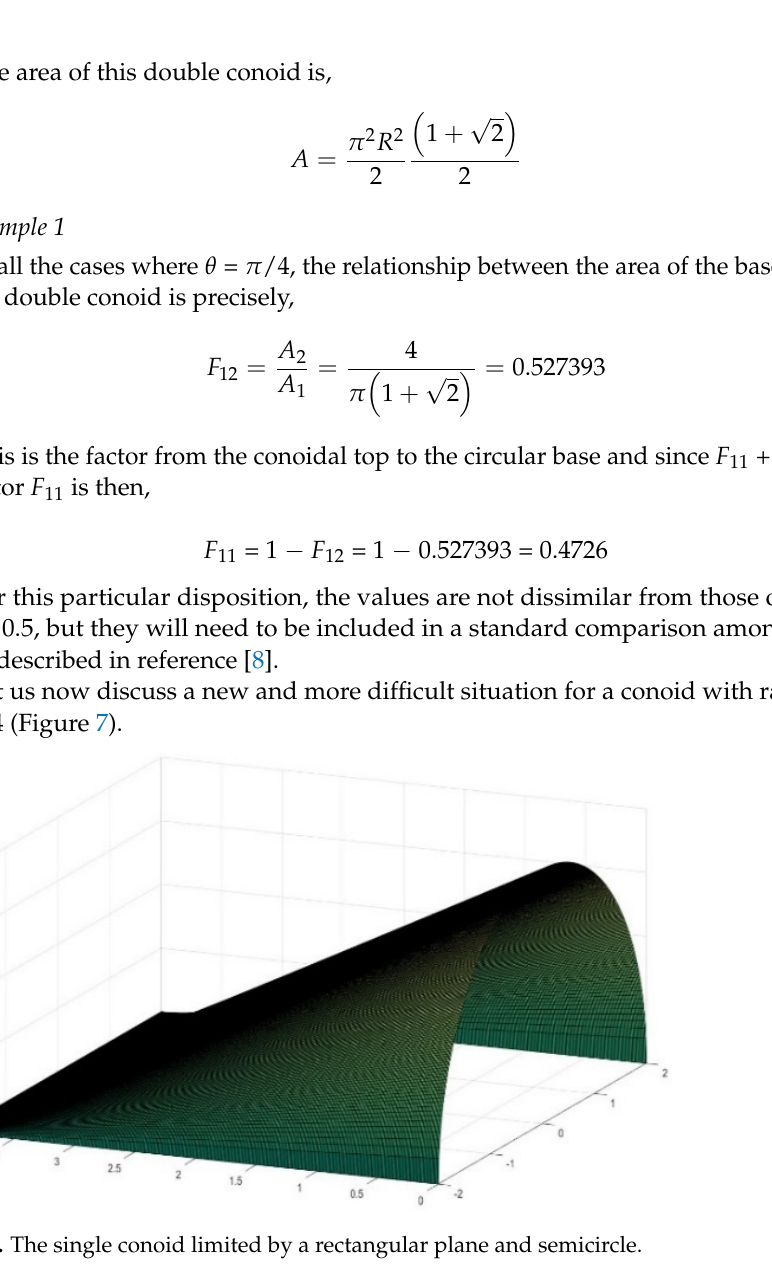
Figure 7. The single conoid limited by a rectangular plane and semicircle.